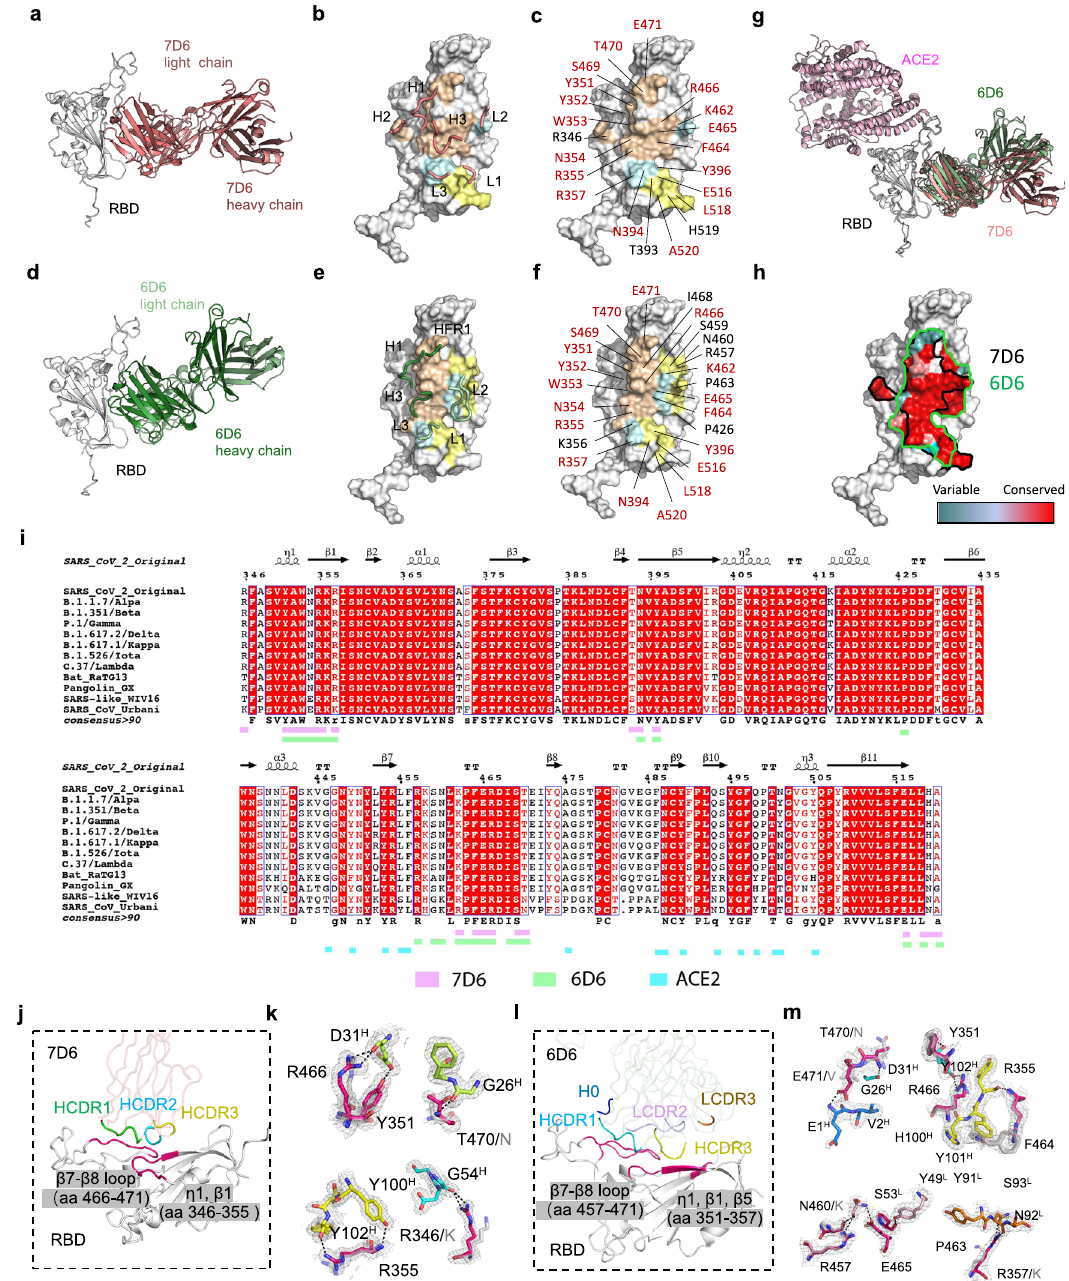
Fig. 3 Crystal structures of 7D6 and 6D6 in complex with SARS-CoV-2 RBD. a , d Overall structures of 7D6:RBD and 6D6:RBD. b , e CDRs of 7D6 ( b ) and 6D6 ( e ) involved in the interactions. RBDs and CDRs are shown as surface and cartoon, respectively. The contact surfaces of the heavy and light chains on the RBD are colored in orange and yellow, respectively; residues contacting both the heavy and light chains are colored in cyan. c , f Residues on the RBD involved in the interactions with 7D6 ( c ) and 6D6 ( f ) are indicated; shared residues are labeled in red. g Superimposition of the ACE2:RBD complex (PDB: 6M0J) and our immune complexes, revealing no competition between ACE2 and the mAbs. h Conservation analysis of critical residues in the binding epitopes for 7D6 (outlined in black) and 6D6 (outlined in green). SARS-CoV-2 (N = 2,216,094) and other SARS-related (N = 83) genes encoding for Sarbecovirus spike proteins were selected to calculate conservation. Deeper red indicates more conservation. i Sequence alignment of the RBDs of various Sarbecoviruses. Secondary structure distribution is indicated according to the RBD structure in 7D6:RBD co-crystal structure (PDB no. 7EAM). The plot was prepared by the online server (https://espript.ibcp.fr/ESPript/cgi- bin/ESPript.cgi). The footprints of ACE2, 7D6, and 6D6 are marked in cyan, pink, and green, respectively. j Interaction between the 7D6 heavy chain variable region and the RBD. The contact region on the RBD is colored purple, and HCDR1-3 are colored in green, cyan, and yellow, respectively. k Hydrogen bonds (dashed lines) between 7D6 and RBD. The electron density (2Fo − Fc) map of all residues is displayed on the contour level of 1 σ above the mean value. Conserved residues between SARS-CoV-2 and SARS-CoV are shown in stick mode and in the same color scheme as in ( j ) for SARS-CoV-2 and in gray for SARS-CoV. l Interactions between the 6D6 CDRs and RBD. The contact region on the RBD is colored in purple; H0, HCDR2, HCDR3, LCDR2, and LCDR3 are colored in dark blue, cyan, yellow, pink, and orange, respectively. m Hydrogen bonds (dashed lines) between 6D6 and RBD.